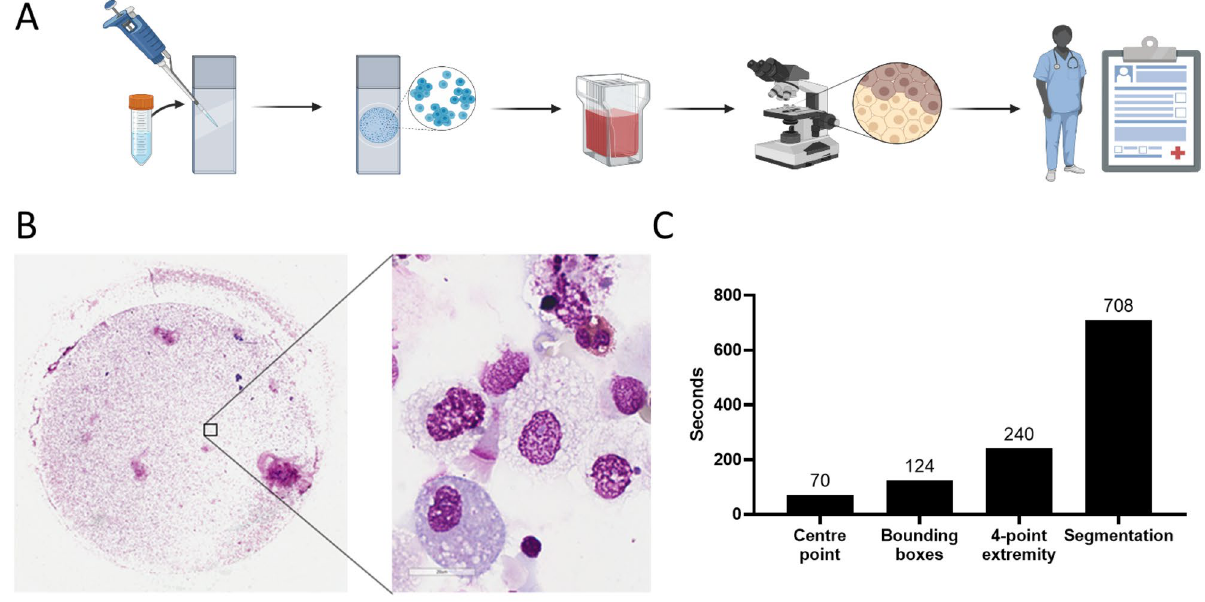
Figure 1. Cytospin generation and annotation. ( A ) The cell fraction of bronchoalveolar lavage or sputum was applied to glass slides by centrifugation, stained with May Grumwald Giemsa based solutions and then digitally imaged by microscopy. ( B ) Representative digital images at × 4 (overview) and × 100 magnification (inset). ( C ) Average time in seconds for assessors to annotate a × 100 magnification sample image tiles by four separate annotation modalities. Lower is better. Figure 1A created with